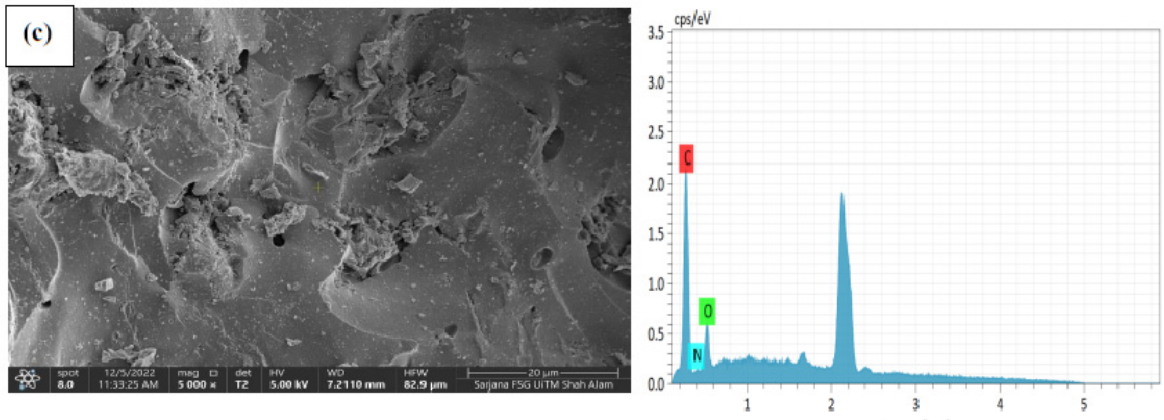
Figure 3. SEM images and EDX spectra of ( a ) MC, ( b ) MCAC, and ( c ) MCAC after MV 2B adsorp- tion.